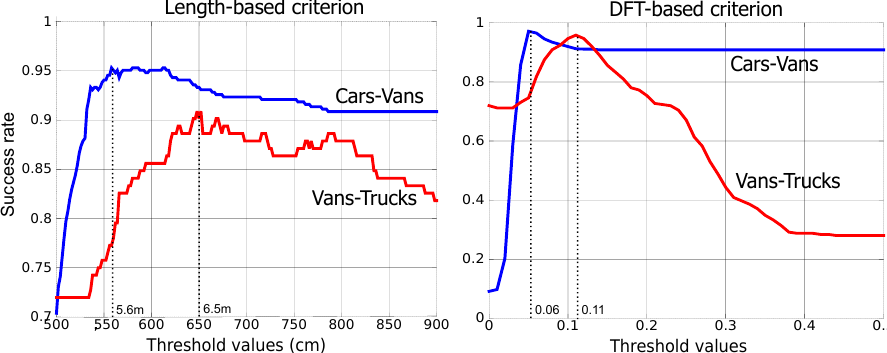
Figure 8. Experimental results: Sucess rates for different threshold values.